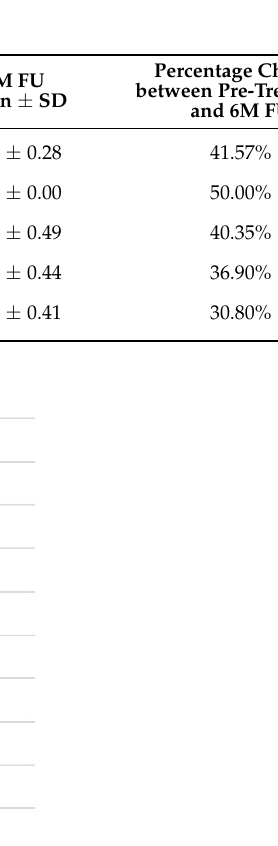
Table 1. Parameters of Manchester Scar Scale and mean scores related to each parameter at 3M FU and 6M FU.